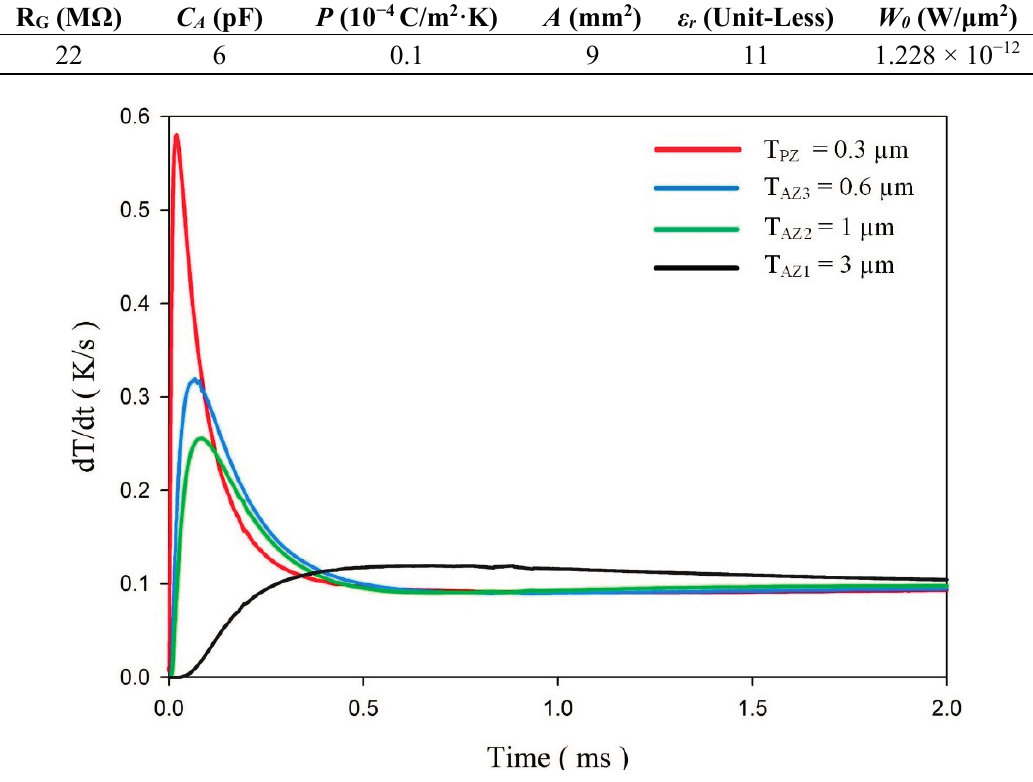
Figure 8. Relationship between the temperature variation rate and time at points PZ 5 , AZ1 5 , AZ2 5 and AZ3 5 in a meliorated multi-frequency band pyroelectric sensor under sputtered ZnO film with a constant thickness of 0.3 μ m and aerosol ZnO films with three thicknesses from 0.6 to 3 μ